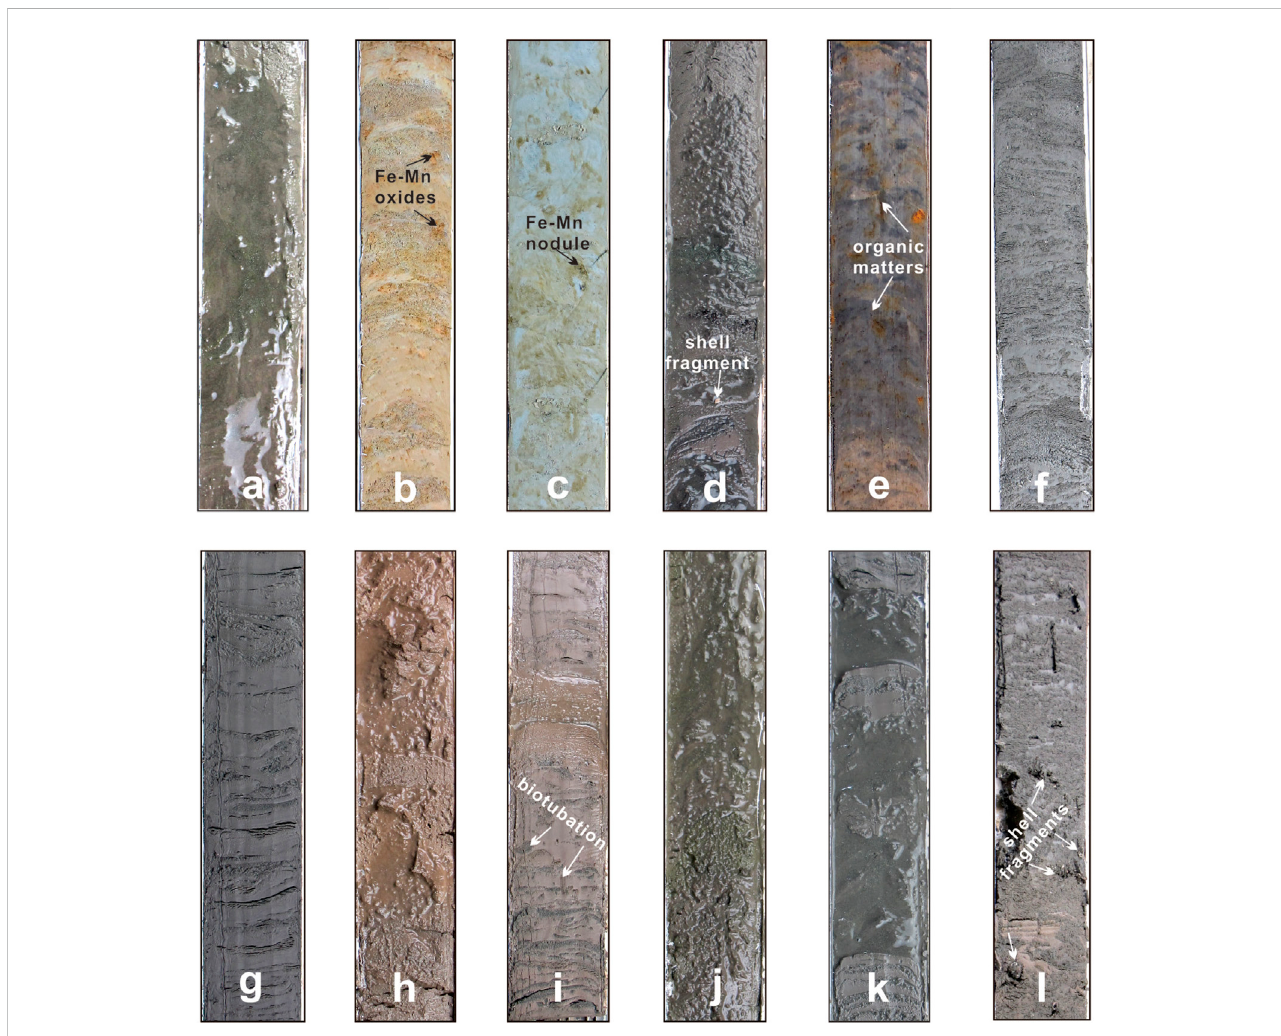
FIGURE 3 Representative photographs of facies in the Jiangsu coastal plain and radial tidal sand ridges. (A) River channel (depth 18.7 – 19.16 m) in the core JSWZK02; (B) fl oodplain(depth13.4 – 13.87 m) inthecore JSWZK05; (C) lacustrinebog(depth59 – 59.4 m) inthecore JSWZK03; (D) tidal riverchannel (depth 31 – 31.4 m) in the core JSWZK01; (E) supratidal fl at (depth 1.8 – 2.2 m) in the core JSWZK01; (F) tidal fl at (depth 9.7 – 10.1 m) in the core JSWZK05; (G) lagoon (depth 9.6 – 10 m) in the core JSWZK01; (H) delta front (depth 18.7 – 19.1 m) in the core JSWZK02; (I) prodelta (depth 11.8 – 12.2 m) in the core JSWZK08; (J) tidalsandridge(depth13.4 – 13.8 m)inthecoreJSWZK05; (K) tidalsand fl ank(depth20.9 – 21.3 m)inthecoreJSWZK03;and (L) offshore(depth7.4 – 7.8 m) in the core JSWZK10. All column lengths are 40